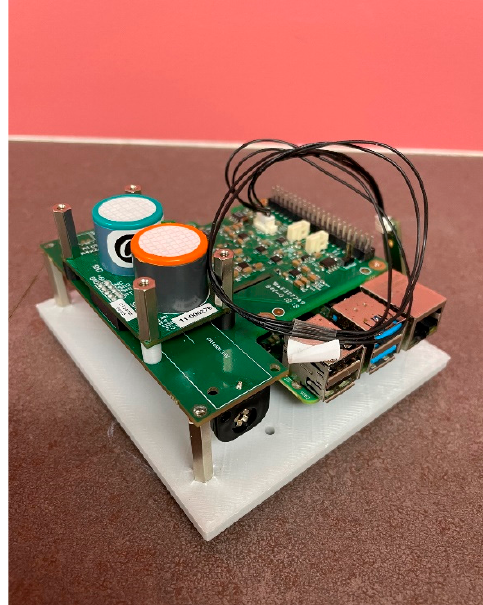
Table 1. Composition of “zero air” used for purging environmental